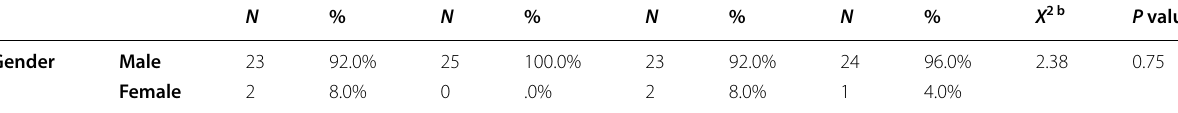
b Fisher’s exact